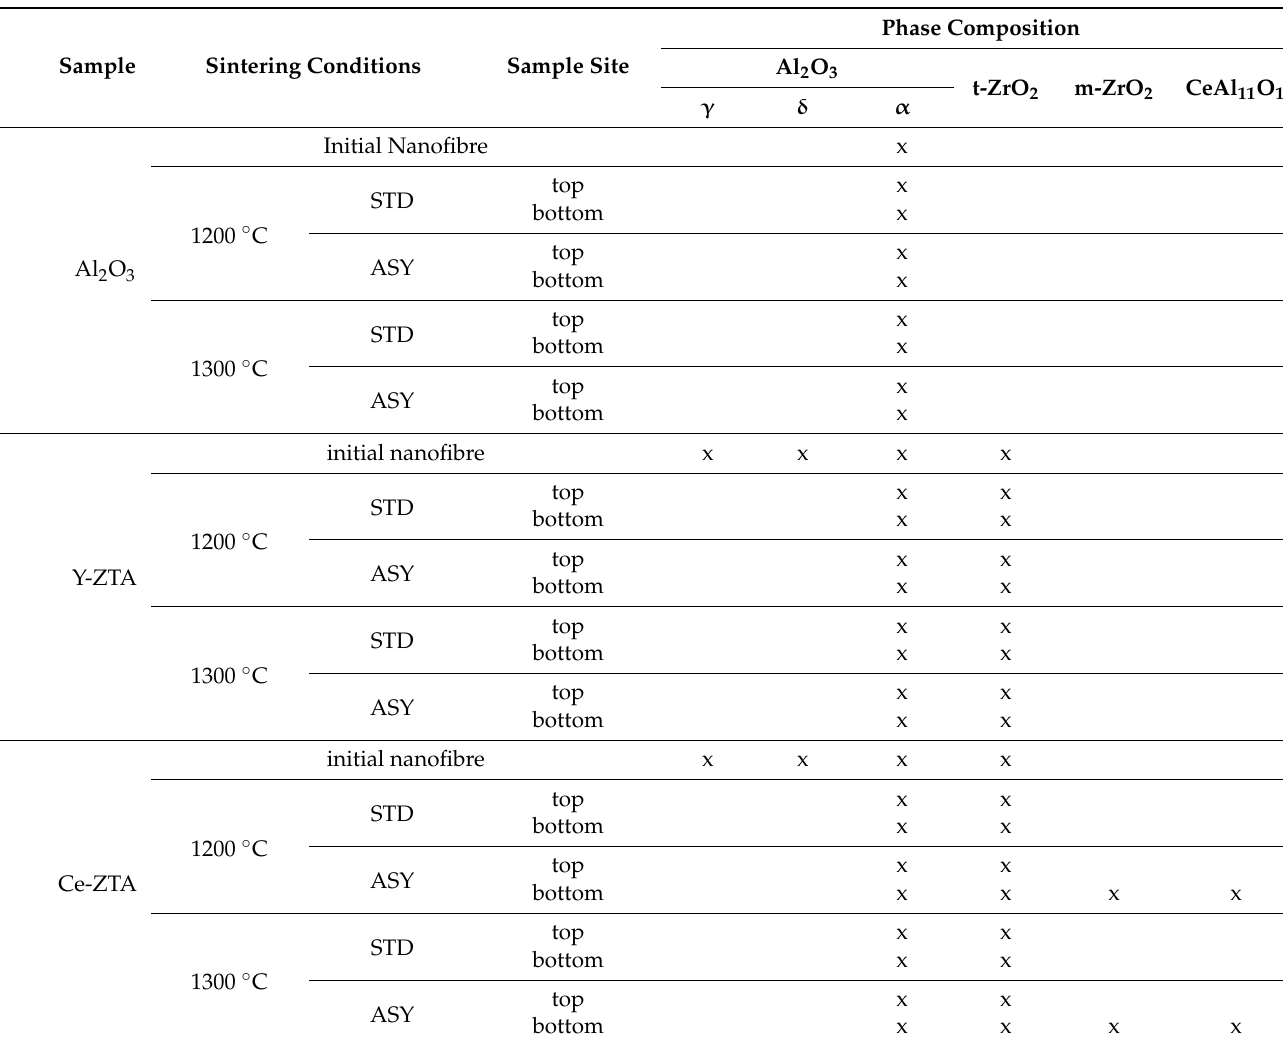
Table 1. Phase composition of the